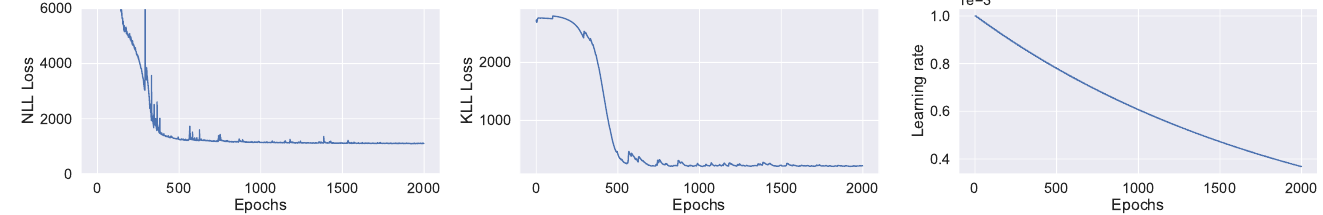
Figure 9. Learning curve of training a BNN model to forecast PM-values. ( Left: ) negative log-likelihood loss; ( Center: ) KL loss estimated using MC sampling; ( Right: ) learning rate of exponential decay.